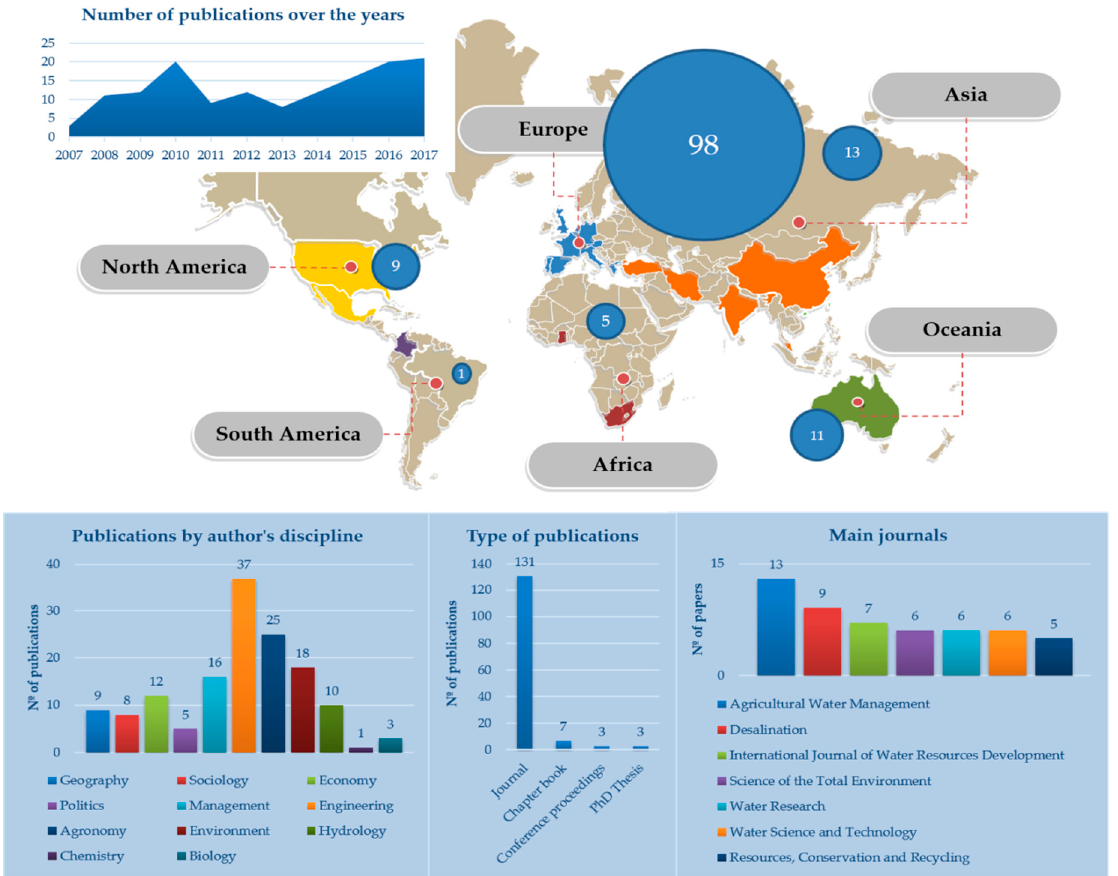
Figure 1. Geographic analysis of selected publications by typology, year of publication, source and author’s discipline. Adapted from Sattler et al. [58]. Note: Template courtesy of www.yourfreetemplates.com.